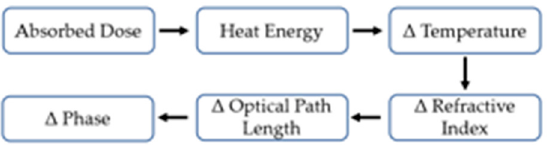
Figure 3. Flow diagram detailing the connection between the irradiation of the water cell and the measurement of phase by the OC dosimeter. The radiation deposits the dose, which transfers energy to the water as heat. This raises the temperature of the water, thereby increasing its refractive index. This causes an increased optical path length of a light wave probing the water, resulting in a change in the phase of the light wave.